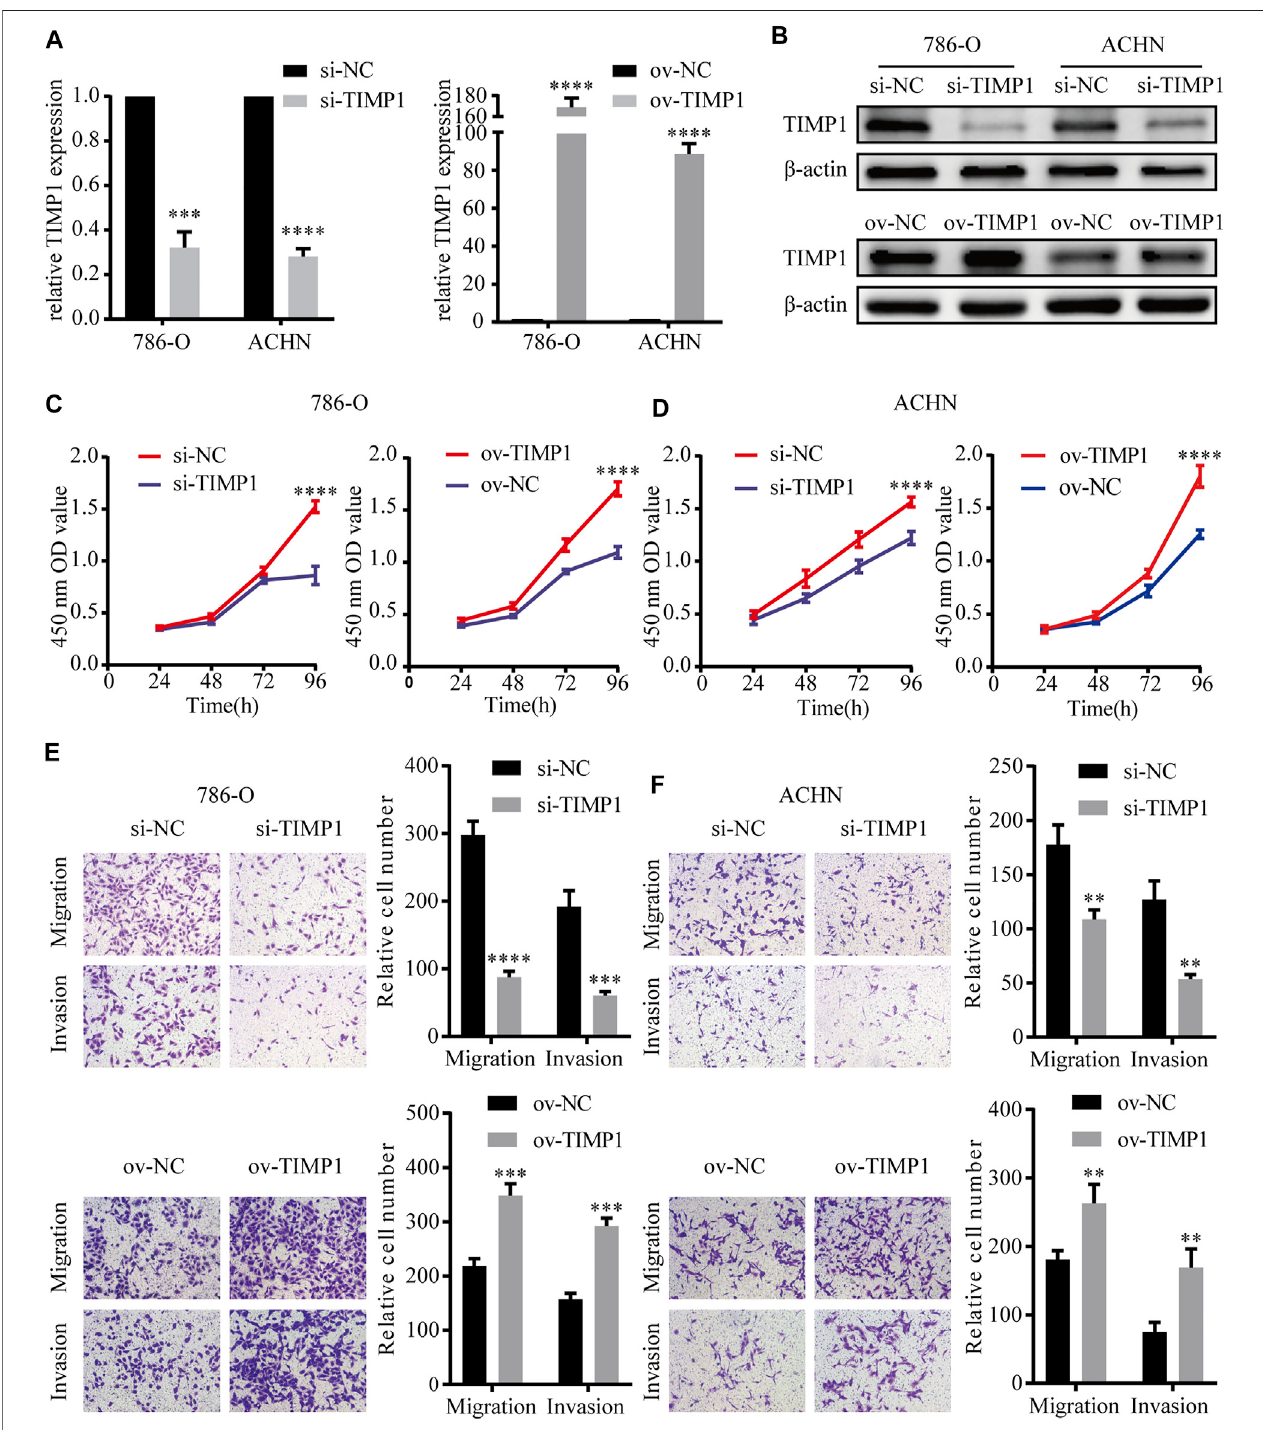
FIGURE8| TIMP1promotedtheproliferation,migrationandinvasionofRCCcells. (A) Veri fi cationofTIMP1mRNAlevelsintransfected786-OandACHNcelllines. (B) Veri fi cation of TIMP1 protein levels in 786-O and ACHN cell lines after knocking down or overexpressing TIMP1. (C,D) Cell growth curves of CCK8 assays for transfected 786-O and ACHN cell lines toevaluate cell proliferation. (E,F) Transwell assaysfor transfected ACHN and 786-O cells toevaluate cell migration and invasion ability (Magni fi cation: ×100). All results were plotted as the means ± SEM from three independent experiments. **** p < 0.0001, *** p < 0.001, ** p < 0.01. TIMP1, Tissue inhibitor matrix metalloproteinase